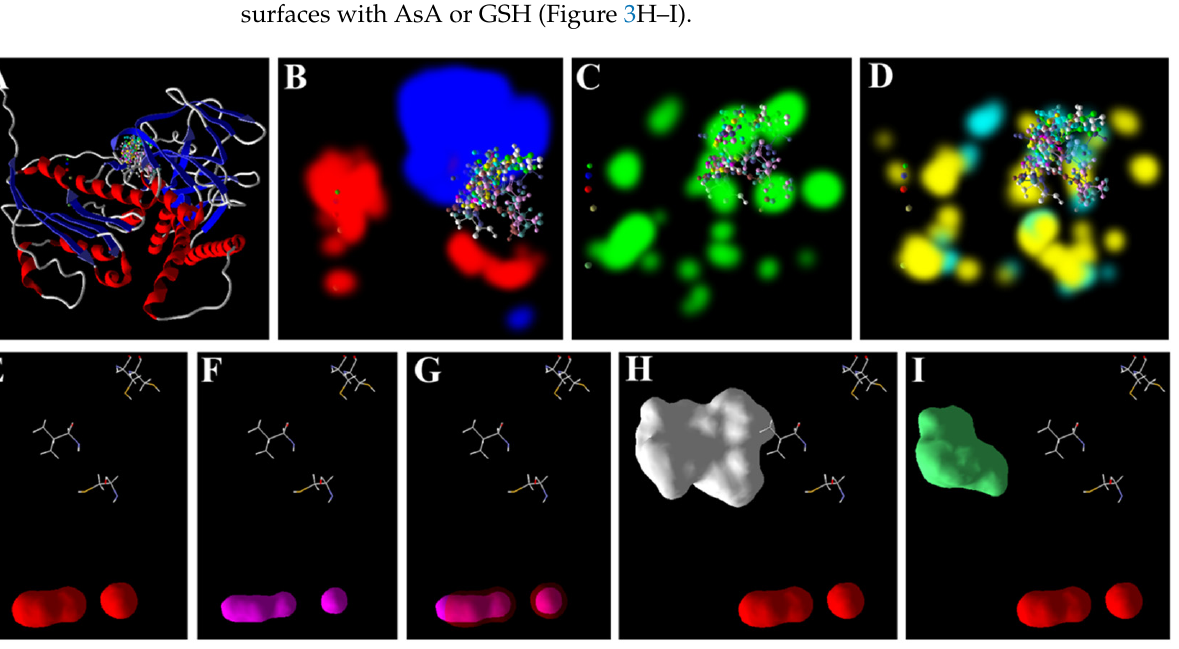
Figure 2. Poses and interactions of ligands and catalase: ( A ) Docked poses of all the ligands. The surface of the receptor favors ( B ) electrostatic, ( C ) stearic and ( D ) hydrogen bond interactions. Elec- trostatic surface of ( E ) As 3+ , ( F ) Zn 2+ , and overlapping surfaces of ( G ) As 3+ and Zn 2+ , ( H ) As 3+ and GSH, ( I ) As 3+ and AsA, and ( J ) As 3+ and H 2 O 2 . Poses and surfaces were developed using MVD.